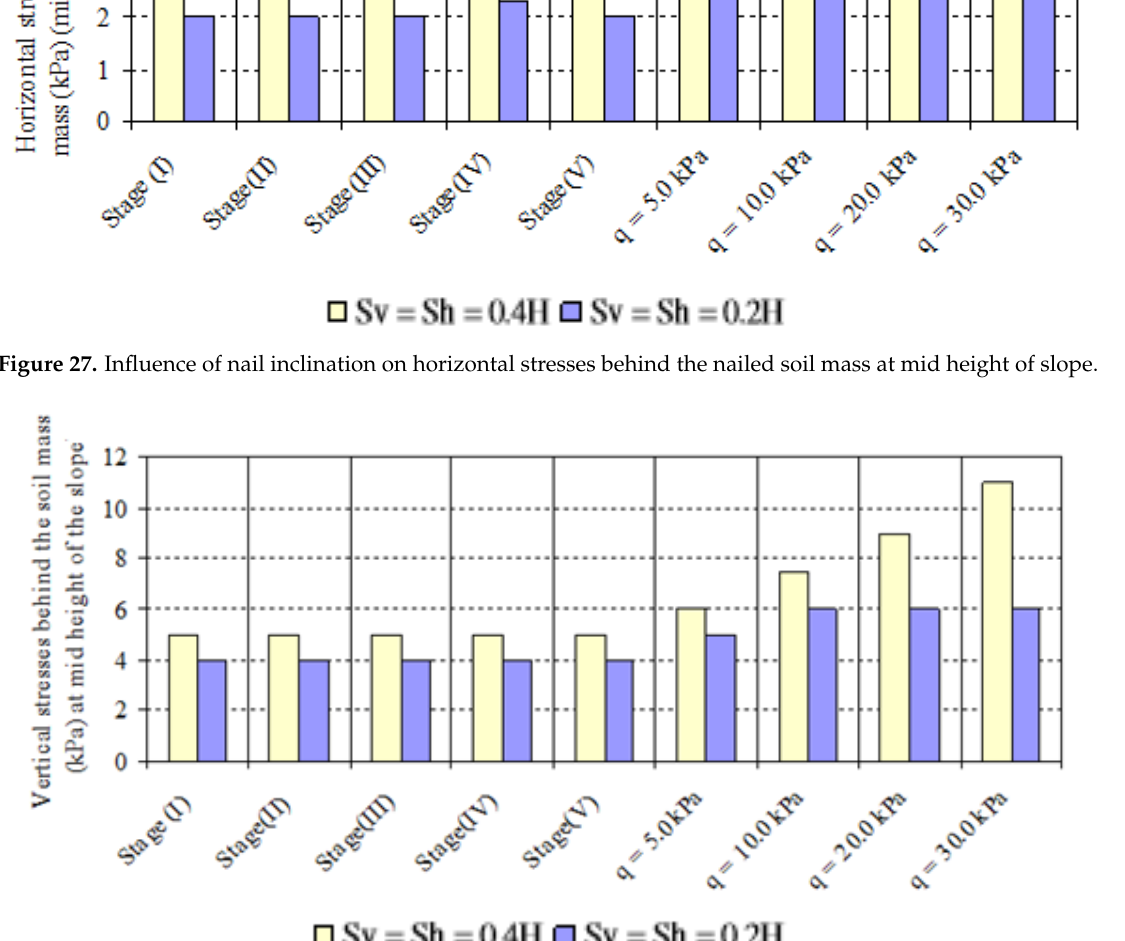
Figure 28. Influence of nail inclination on vertical stresses behind the nailed soil mass at mid height of slope.